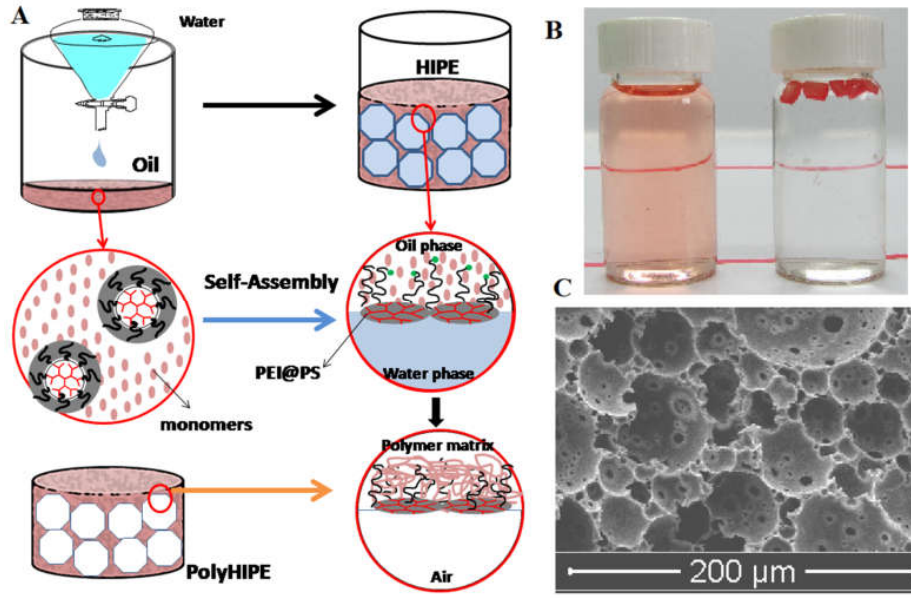
Figure 4. Schematic of dendritic macrosurfactants (PEI@PS)-mediated polyHIPE ( A ), adsorption of Congo Red by the polyHIPE ( B ), and ( C ) SEM micrograph of the polyHIPE [3]. Reproduced